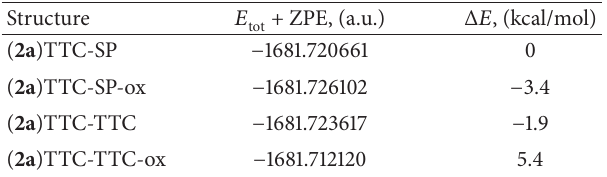
Table 1: Full energies including zero point energy correction 𝐸 + ZPE (a.u.) and relative energies Δ𝐸 (kcal/mol) of isomers ( 2a ) and their oxazolidine forms calculated at the CPCM/PBE0/6-311G ∗∗ level of theory (toluene solutions).